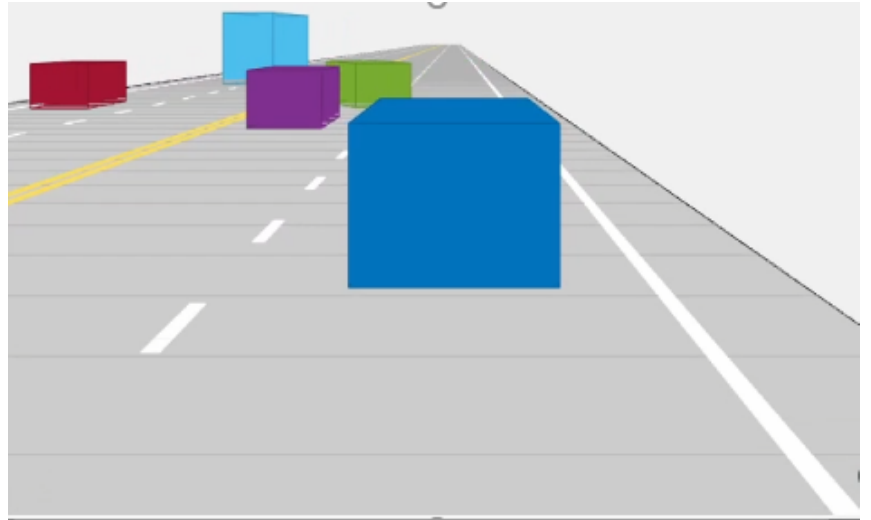
Figure 13. A screenshot of the scenario designed in Driving Scenario Designer. Each color shows a different